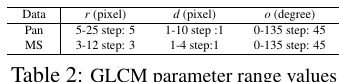
Single variable linear regressions : To retrieve forest struc- ture variables from VHR imagery, we relied on linear regressions between each of the 7 typical forest structure variables to be esti- mated and various textural features (first order and Haralick’s fea- tures). The Pearson correlation coefficient R 2 is used to analyze the correlation between each forest variable and texture features. Each forest variable is modeled as a function of a single texture feature. The best model for each variable is obtained automati- cally by selecting the one with the highest R 2